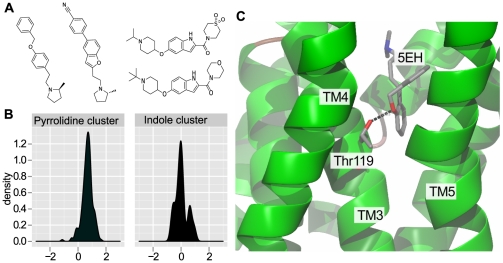
Species specific binding of small molecules for the HRH3.(a) Exemplary compounds from two clusters are shown. (b) Distributions of differences observed for compounds from the two respective clusters. Pyrrolidine containing componds bind the human target with higher affinity, while most compounds with an indole scaffold bind the human and rat HRH3 with equal affinity. (c) The substitution Thr119Ala is represented by a grey threonine side chain in the human receptor. The displayed ligand is the HRH1 antagonist Doxepin (5EH) and the nearest distance to Thr119 is 2.7A.